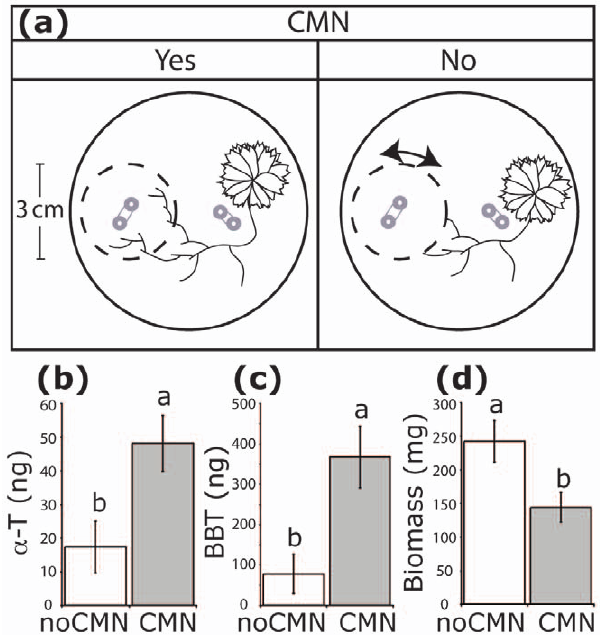
Figure 2. (a) Design of Experiment 2 showing root exclusion compartments (REC) as dashed lines, location of Tagetes plant, and in situ extraction tubing in gray. The CMN is indicated by black lines, and rotation of the REC prevents CMN formation inside. (b–d) Results from Experiment 2 (means 6 SE). Bars with different letters indicate significant differences at a =0.05. (b) Levels of a -T in in situ extraction tubing inside RECs (N=10). (c) Levels of BBT in in situ extraction tubing inside RECs (N=10). (d) Above ground biomass of bioassay plants in REC soil after initial harvest (N=11).